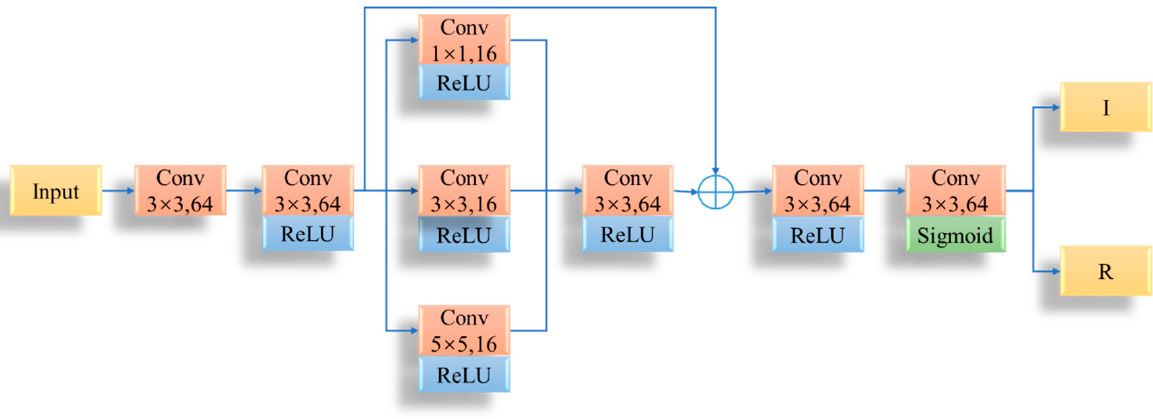
Figure 8. The structure of Decom-Net.